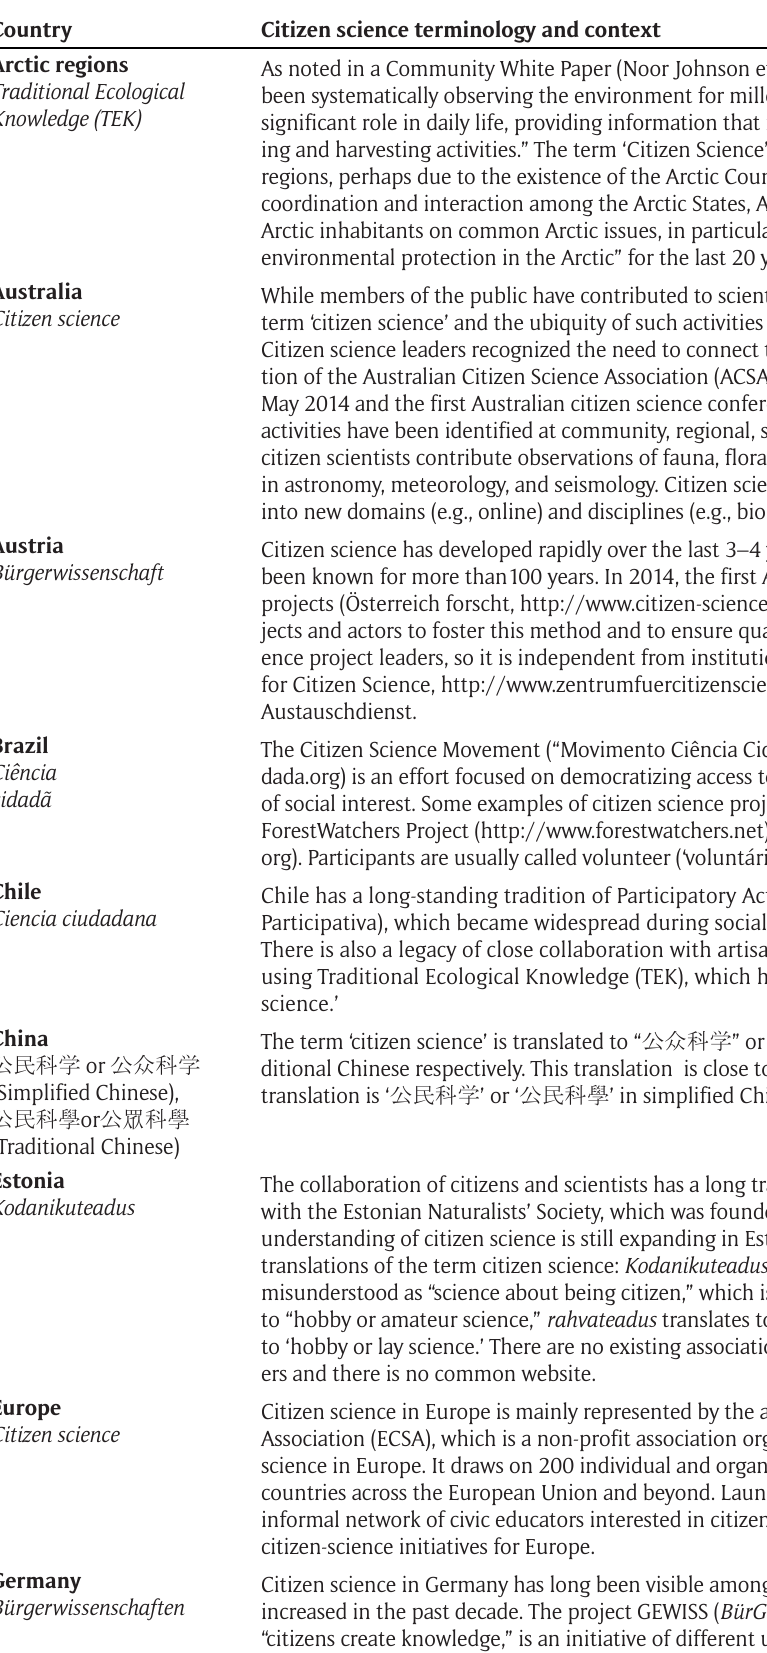
Table 2: Geopolitical contexts, in alphabetical